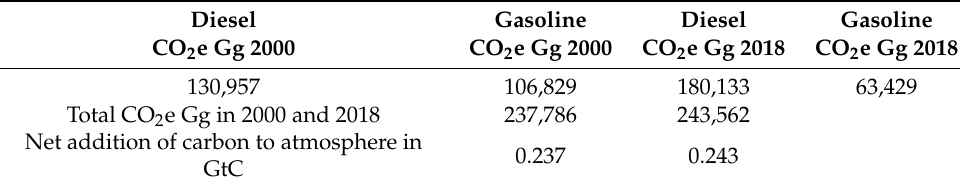
Figure 2. Emitted carbon from diesel and gasoline use by EU member states in 2000 and 2018. Table 1. Diesel and Gasoline carbon emissions in EU 28 (2000 and 2018).